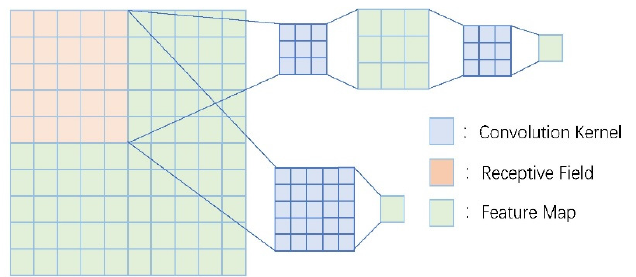
Figure 8. Compared with the large convolution kernel that requires 25 parameters, the small convolution kernel has the advantages of fewer parameters (18 parameters) and deeper network depth under the same receptive field.